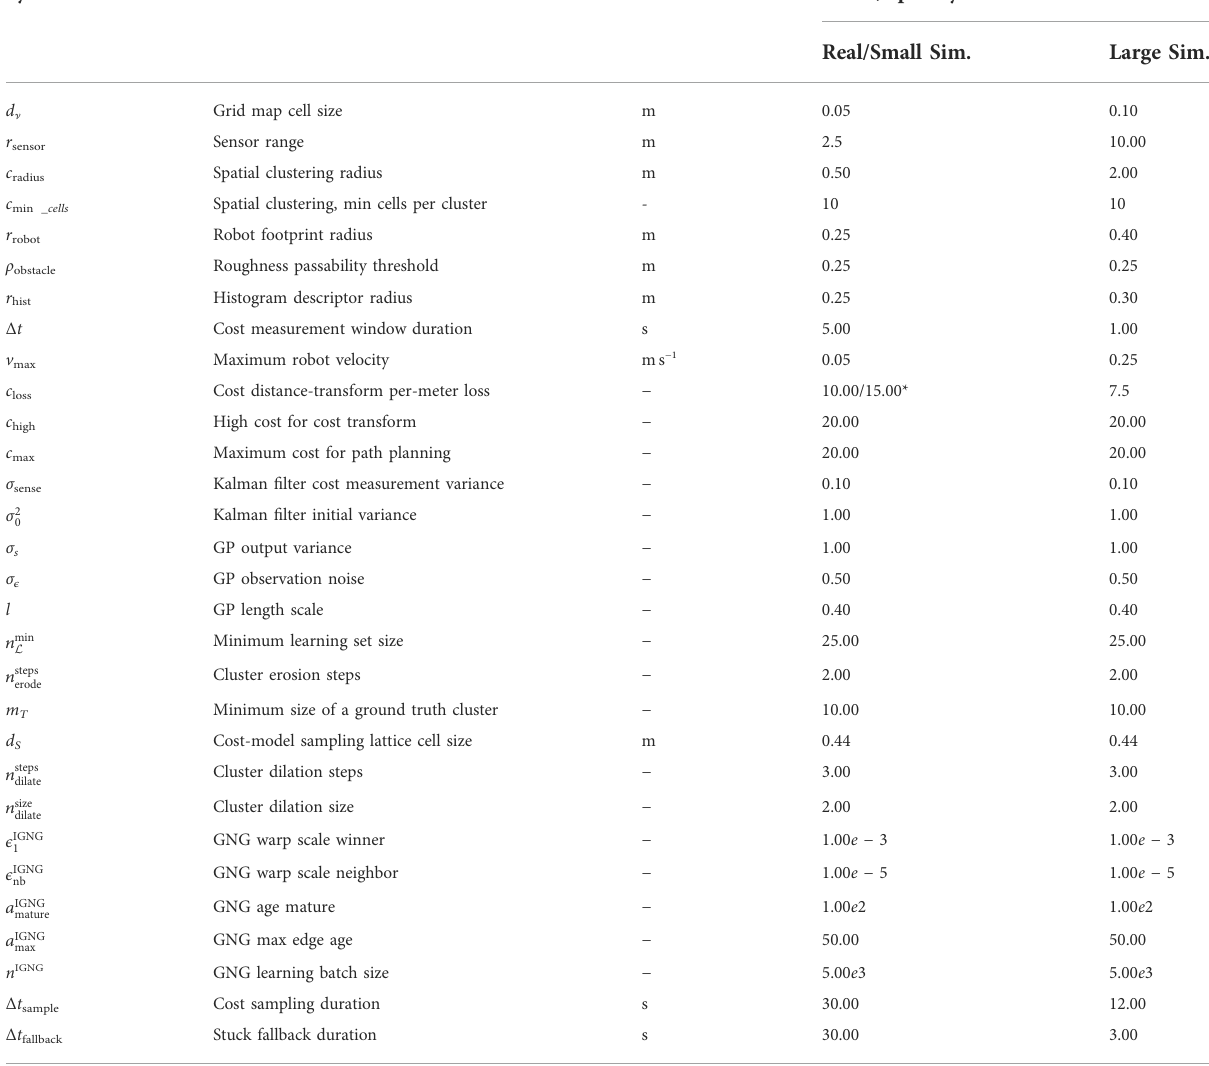
TABLE 3 System parameterization.